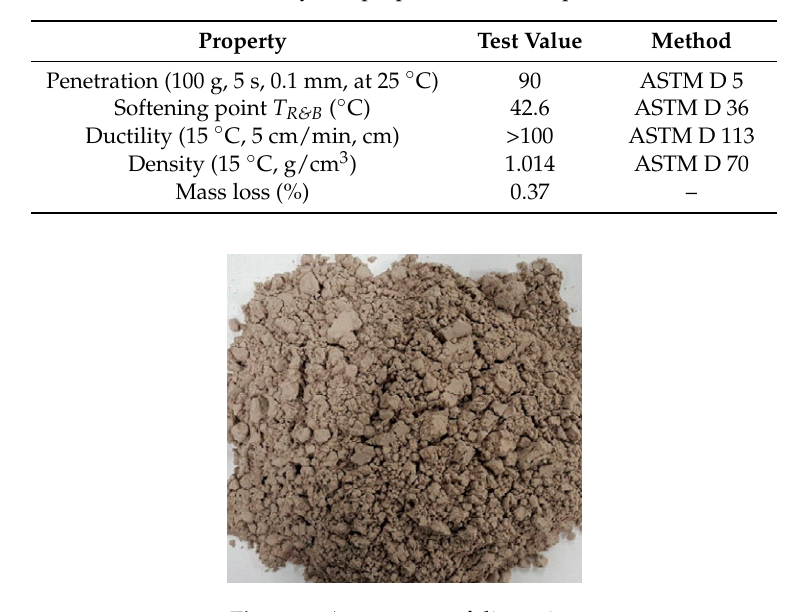
Table 1. Physical properties of neat asphalt.